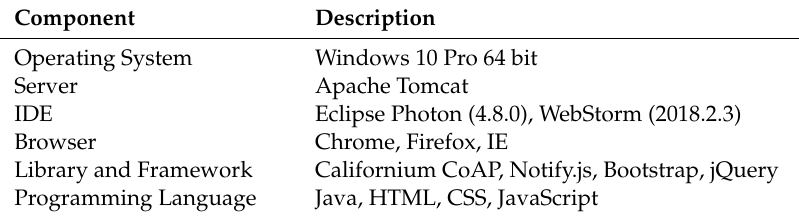
Table 3. Development environment for the blockchain web